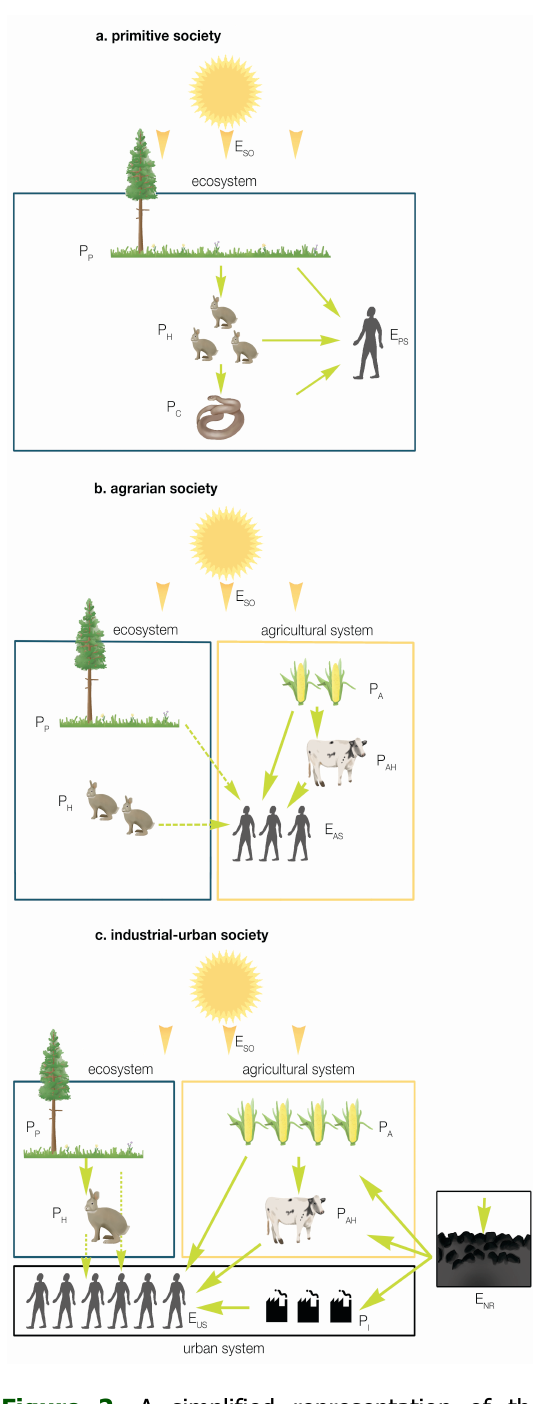
Figure 2. A simplified representation of the energetic relationships between mankind and nature in a) a primitive society; b) an agrarian society; and c) an industrial-urban society (after [33]). Legend of symbols: E = incoming solar SO energy; P = primary production of plant P biomass in the ecosystem; P = production of H herbivores in the ecosystem; P = production of C carnivores in the ecosystem; E = energy needs PS of the primitive society; P = primary production A in the agricultural ecosystem; P = production AH of herbivores in the agricultural ecosystem; E = AS energy needs of the agrarian society; E = NR